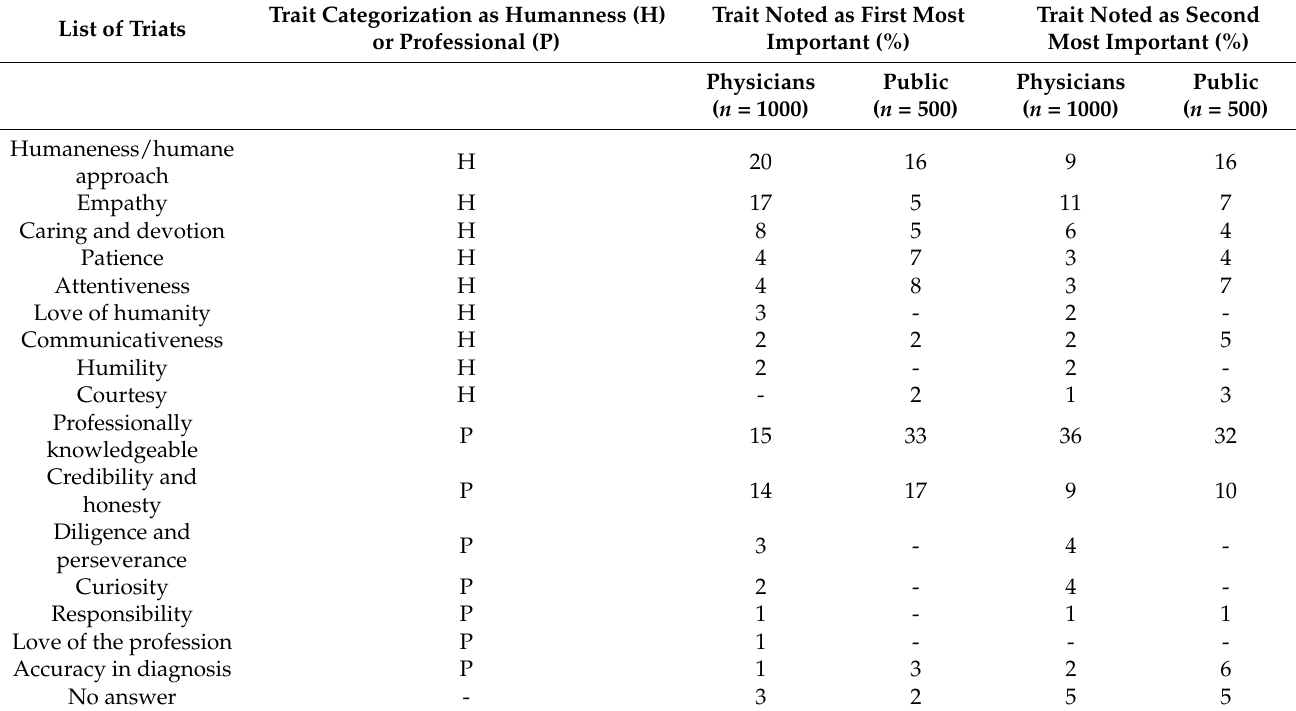
Table 3. Distribution of Views on Key Traits of a “Good